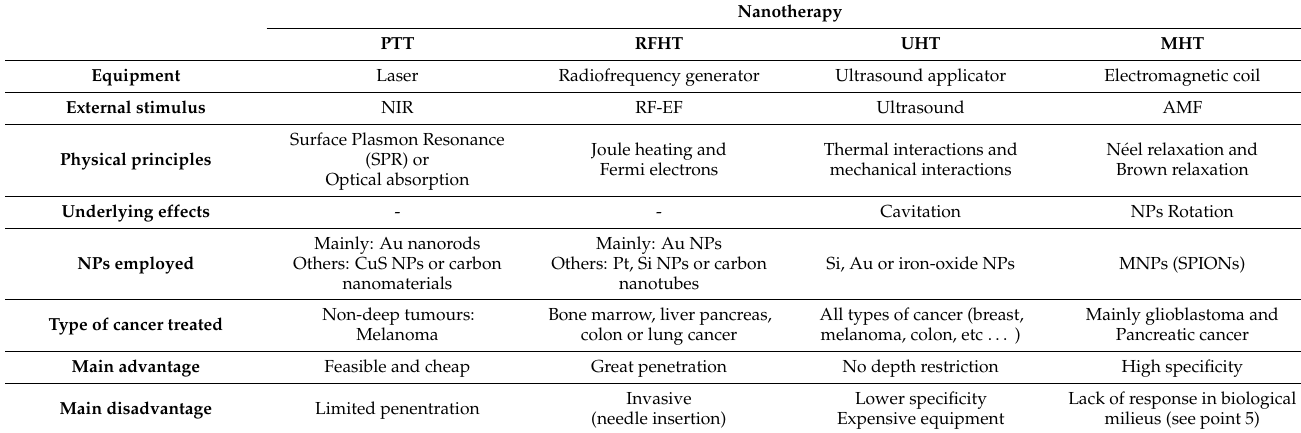
Table 1. Main features of the different